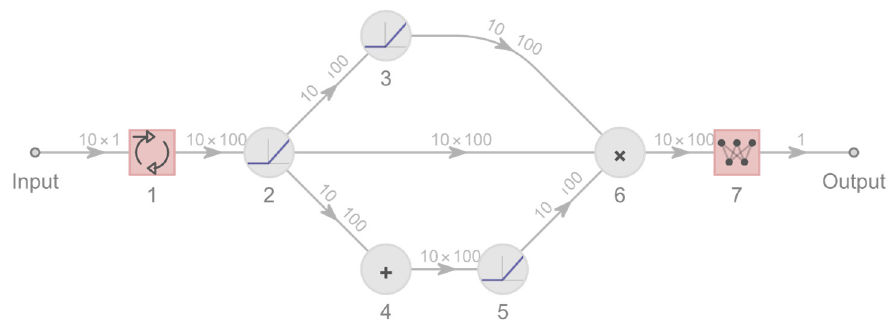
Figure 1. Architecture of artificial neural network with LSTM layer. Source: Author.